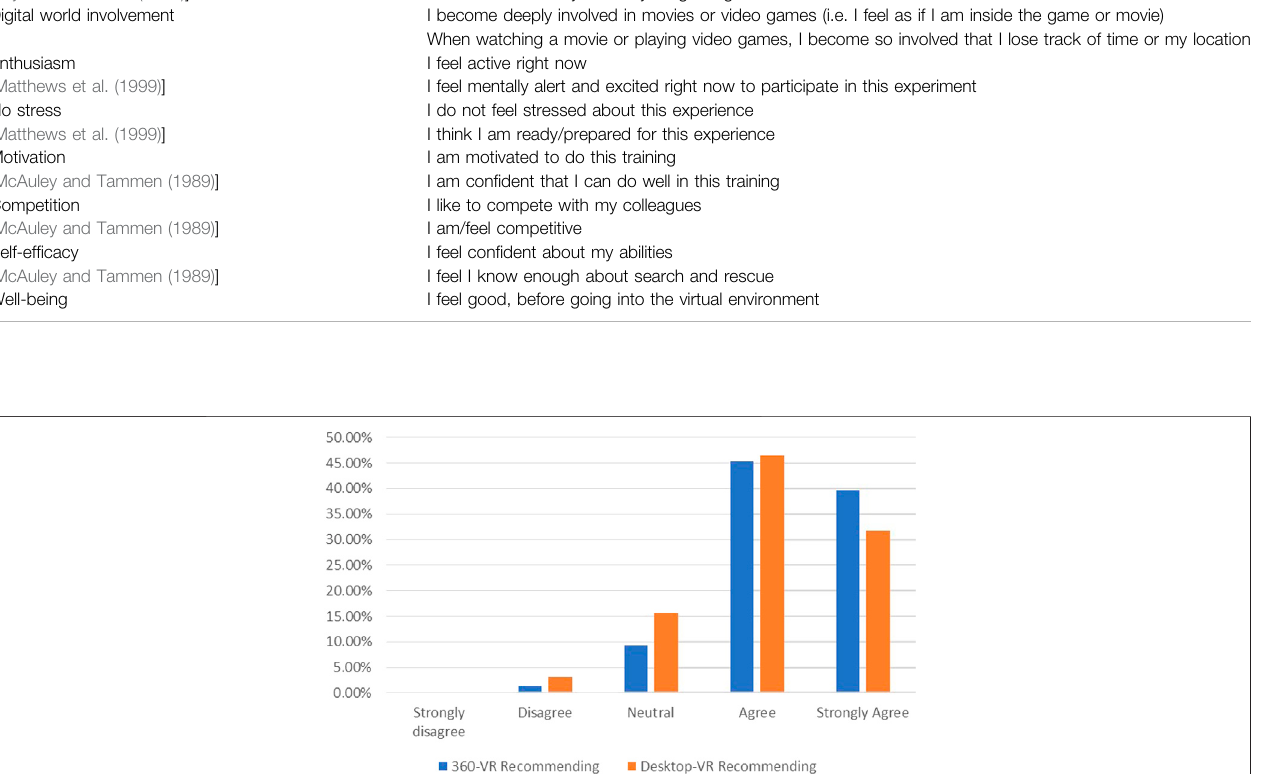
Frontiers in Virtual Reality |